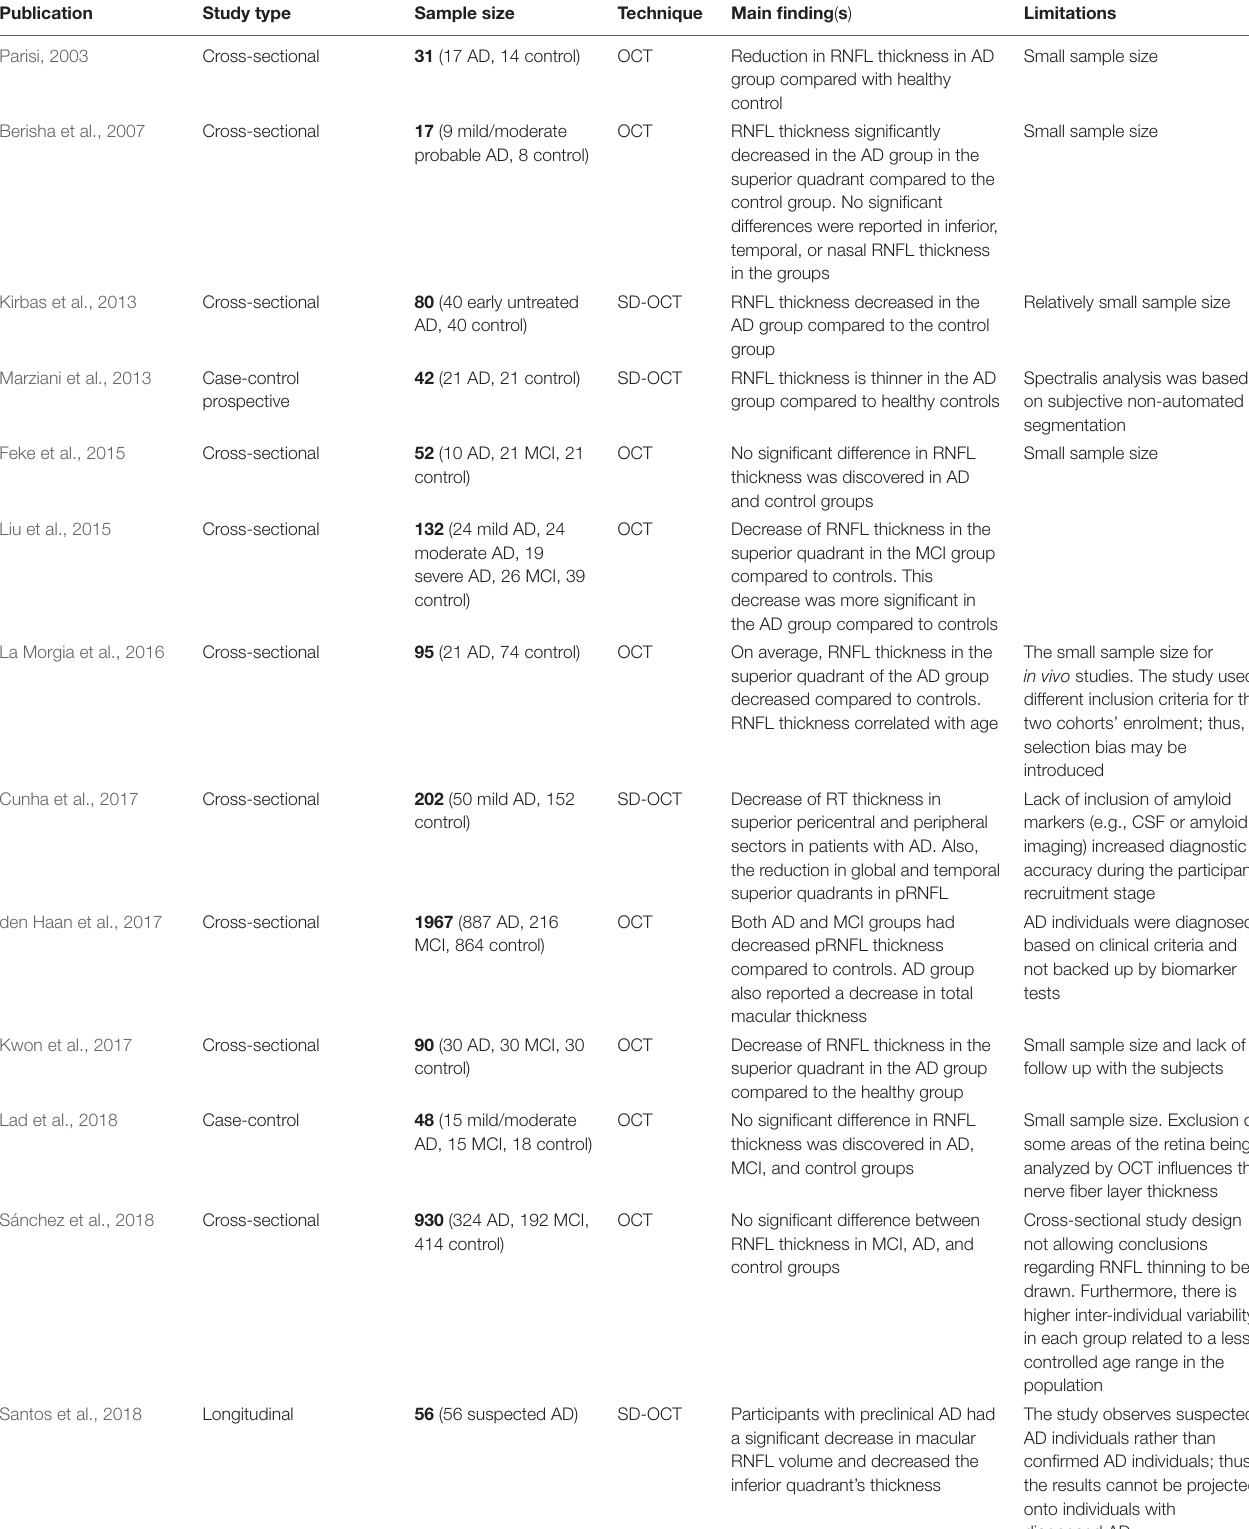
TABLE 2 | Summary of main findings of retinal nerve fiber layer changes from published